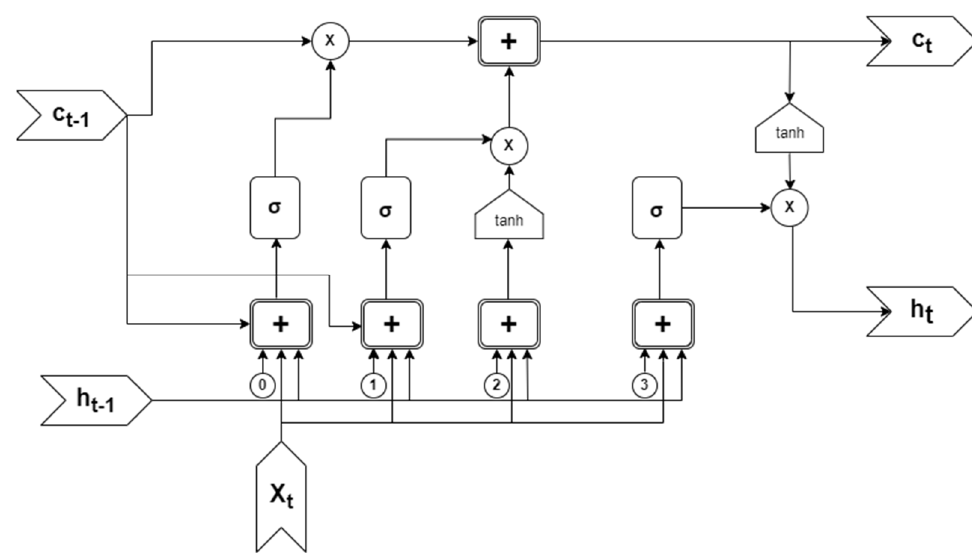
Figure 2. The basic diagram of the long short − term memory (LSTM) neural network (Yan [25]). Similar to LSTM, GRUs are used for enhancement in the hidden cells. GRUs